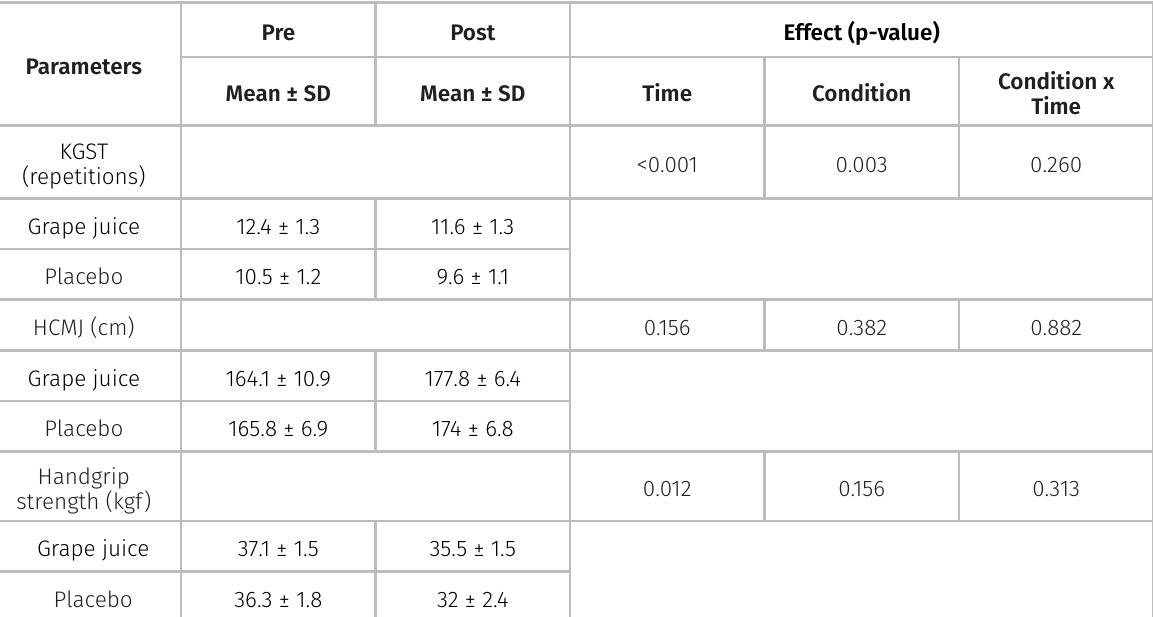
Table II. Muscle fatigue parameters of upper and lower limbs before and after a fight simulation in 20 judo